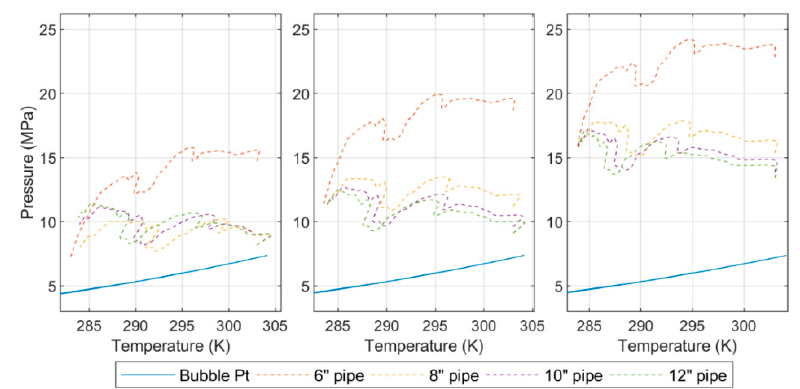
Figure 9. Summary of Pipeline Temperature and Pressure Conditions for the Melkøya CO 2 Pipeline Example. On the left is the 10% reservoir overpressure case, middle 30% and right 50% overpressure.